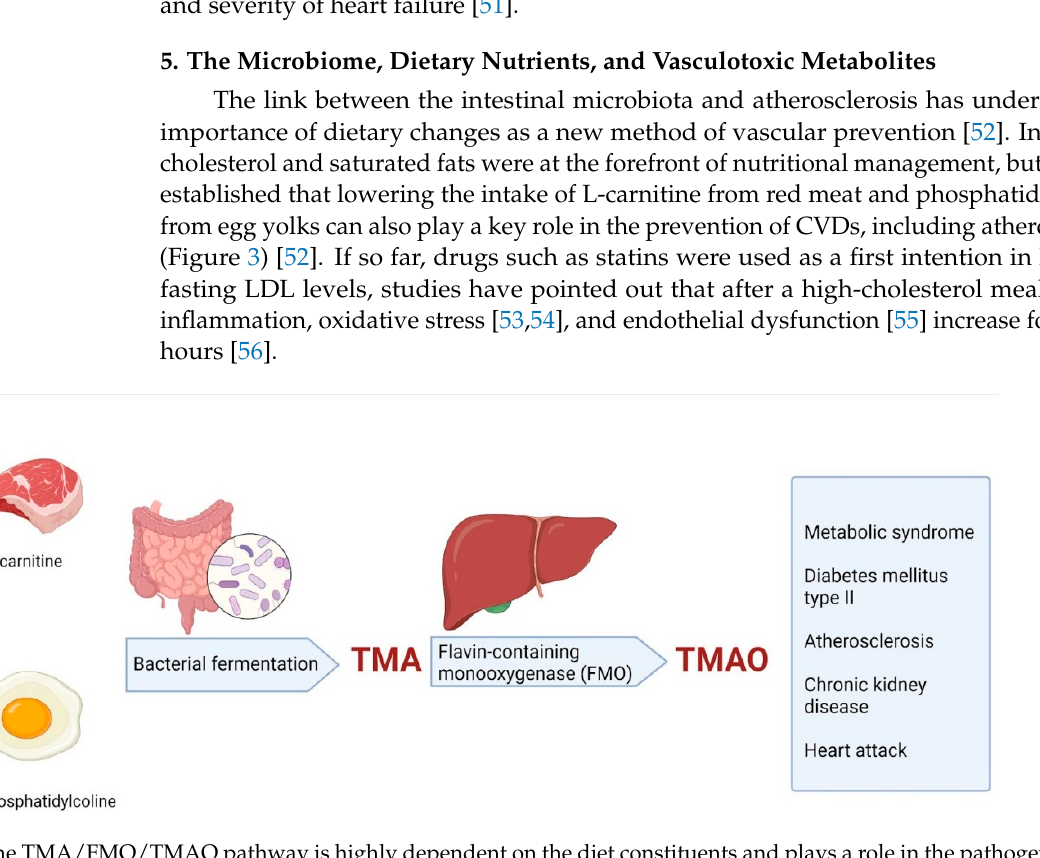
Figure 3. The TMA/FMO/TMAO pathway is highly dependent on the diet constituents and plays a role in the pathogenesis of CVD. Trimethylamine (TMA), resulting from bacterial metabolism, will interact with the enzyme flavin monooxygenase 3 (FMO), which is a powerful modifier of cholesterol metabolism and responsible for trimethylamine N-oxide (TMAO) production. Created with BioRender.com (Last accessed on 21 July 2021).